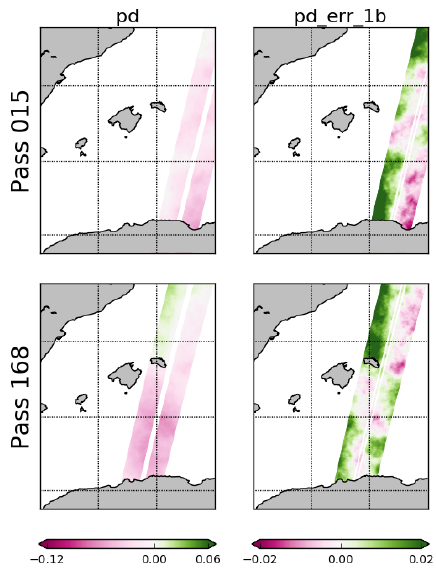
Figure A5. The different geophysical errors (m) for passes 15 and 168 over cycle 2 are shown.